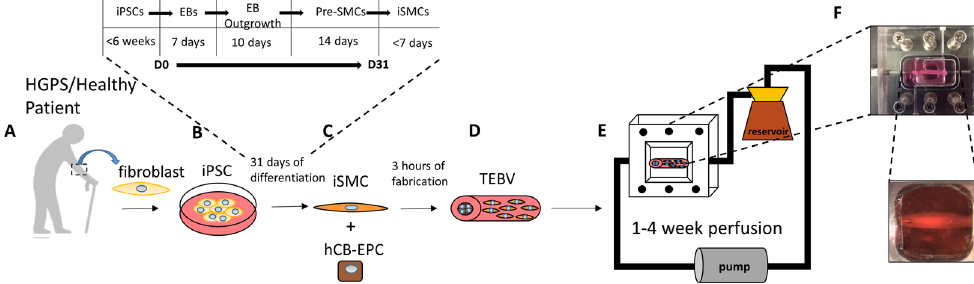
Figure 1. Schematic diagram of the procedure to produce iPSC-derived SMC TEBVs from healthy and HGPS patients. ( A ) A fibroblast biopsy from either healthy (young or old) or HGPS individuals ( B ) is converted to induced pluripotent stem cell (iPSC) cultures. ( C ) iPSCs are then differentiated into induced smooth muscle cells (iSMCs) using a 31-day process as previously described by Xie et al . 21 . ( D ) iSMCs are then incorporated into a dense collagen gel construct that is seeded with human cord blood-derived endothelial cells from a separate, healthy donor on the luminal surface to create iSMC TEBVs using the process previously described by Fernandez et al . 20 . ( E ) iSMC TEBVs are then incorporated into a flow loop and perfused with steady laminar flow at a shear stress of 6.8 dynes/cm 2 for 1 to 4 weeks for maturation and functional characterization studies. ( F ) Photographic images of HGPS iSMC TEBVs in the custom perfusion chambers under perfusion